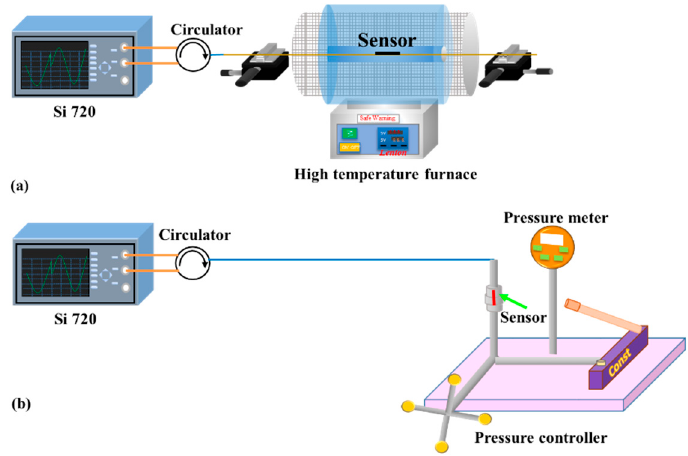
Figure 3. Schematic diagram of the experimental setup. ( a ) Strain and temperature tests; ( b ) pressure test at room temperature.